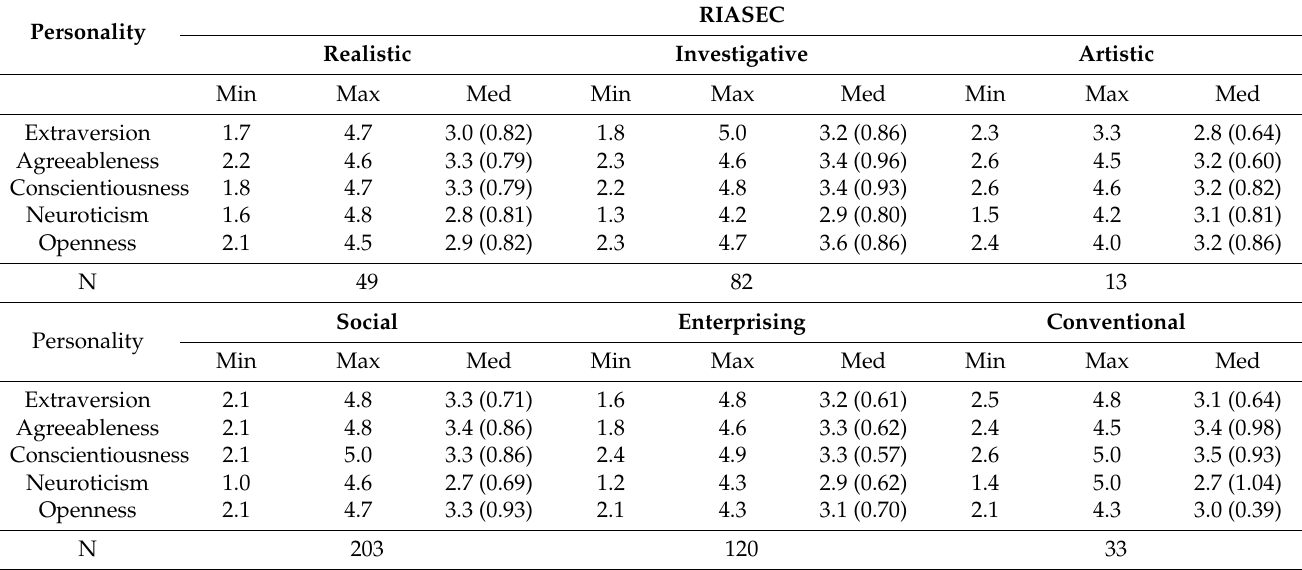
Table 2. Descriptive data of personality dimensions for each RIASEC type.